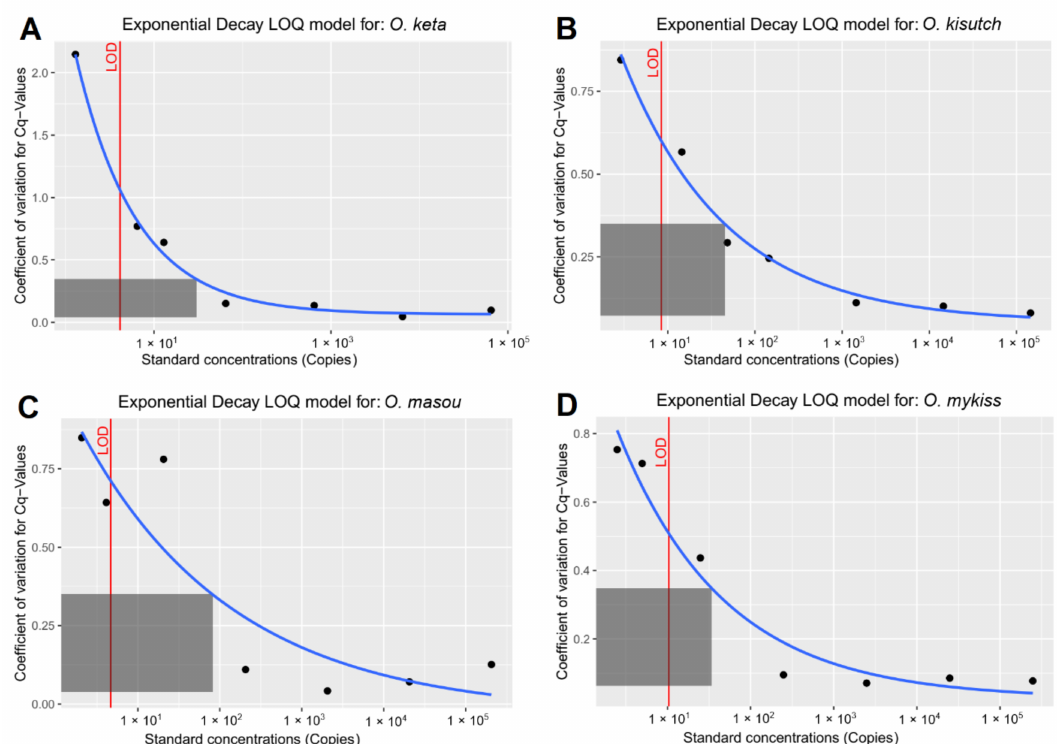
Figure A2. LOQ model for the respective salmon assays generated by plotting standard concentrations against the coefficient of variation (CV) of the Cq values. ( A ) O. keta , ( B ) O. kisutch , ( C ) O. masou , and ( D ) O. mykiss assay. All LOQs were determined by an exponential decay model. The LOD is presented as a vertical red line, the LOQ model is illustrated as a blue line, the gray area indicates 0.35 CV as a defined threshold of the LOQ, and the defined LOQ is determined by the conjoining of the LOQ model and the gray area of the